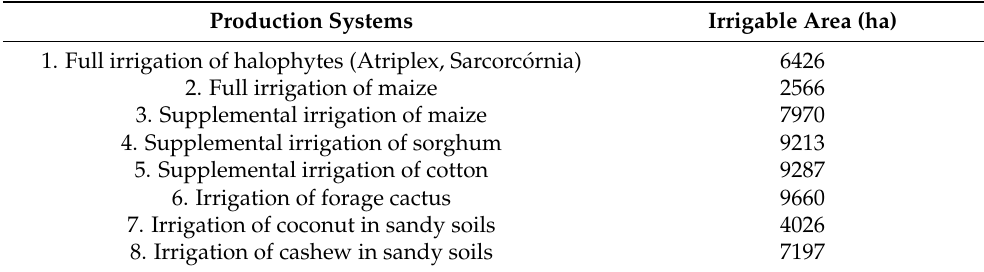
Table 6. Potential of unrestricted irrigable area with brackish water from wells in the Brazilian semi-arid